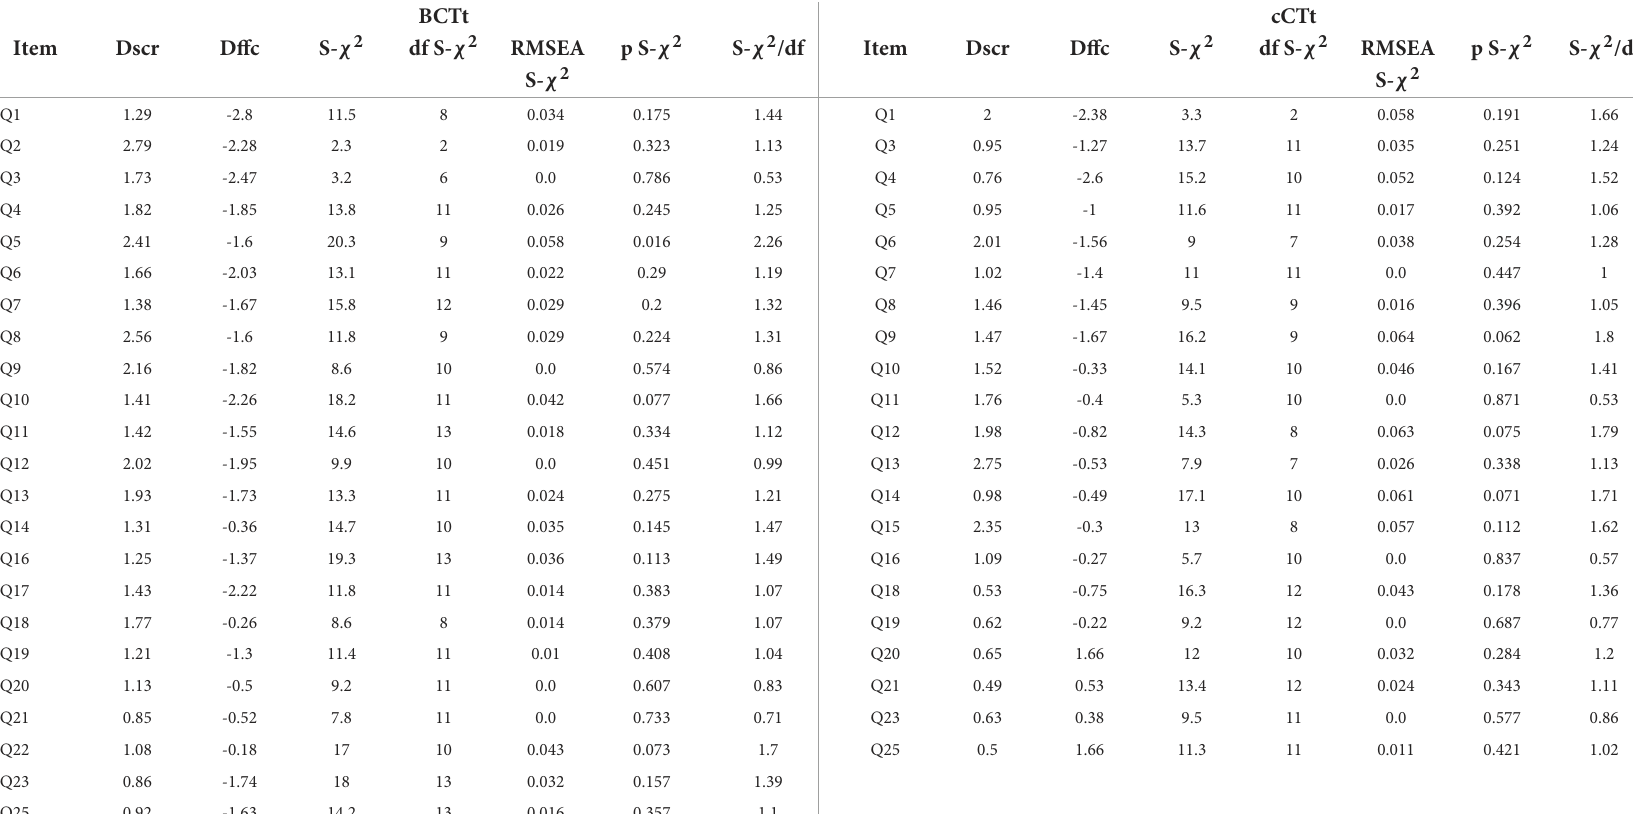
TABLE 7 BCTt and cCTt item parameters and fit